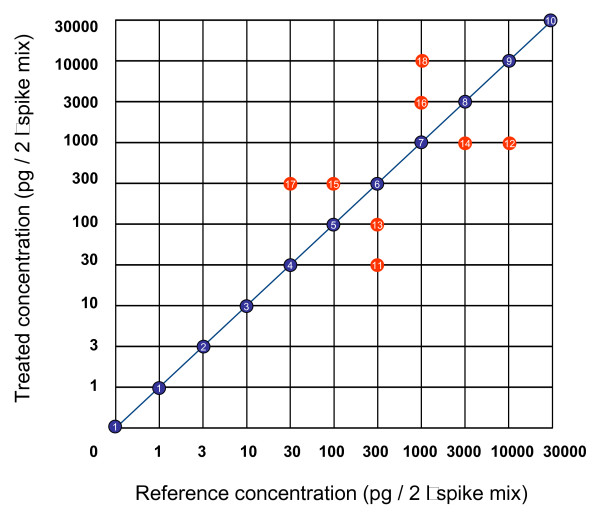
Description of the Lucidea array. The Lucidea array has 9,600 spots from 20 genes; each gene was replicated 480 times. Eight genes were spiked with different mRNA-concentrations in the treated and reference channels (i.e. the DE-genes, red dots 11–18). The remaining 12 genes were spiked equally in both channels at different mRNA-concentrations (i.e. the NDE-genes, blue dots 1–10). Three NDE-genes, two expressed at concentration zero and one at concentration one, were clustered together and are in this paper treated as one gene.